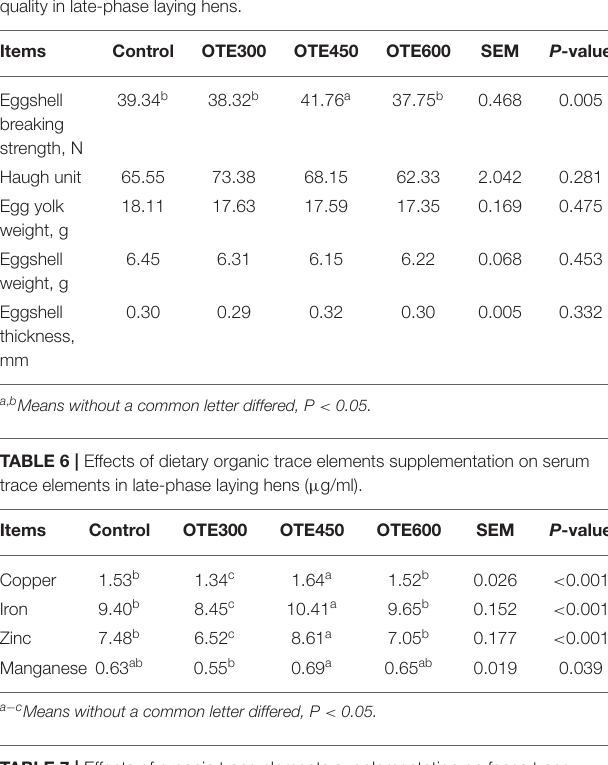
TABLE 5 | Effects of dietary organic trace elements supplementation on egg quality in late-phase laying hens.